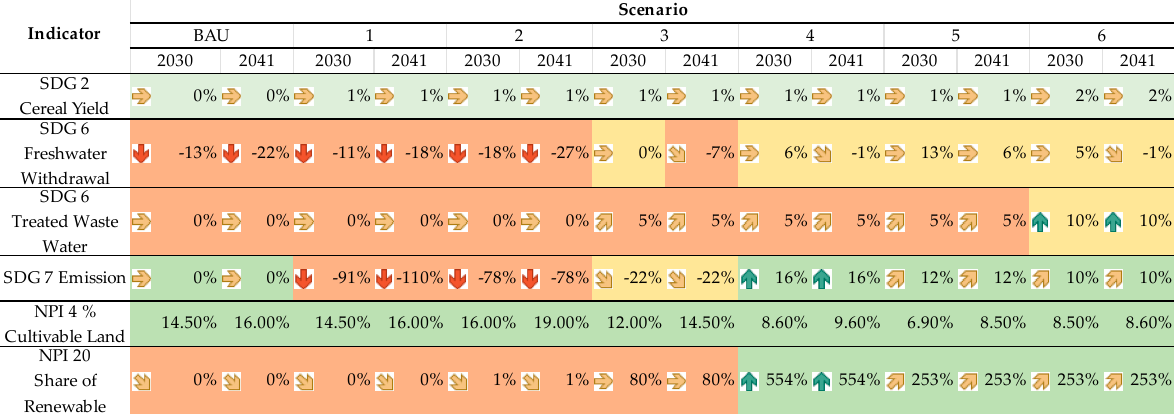
Figure 7. Second Filter-SDG Performance by an assessed value of the indicators.